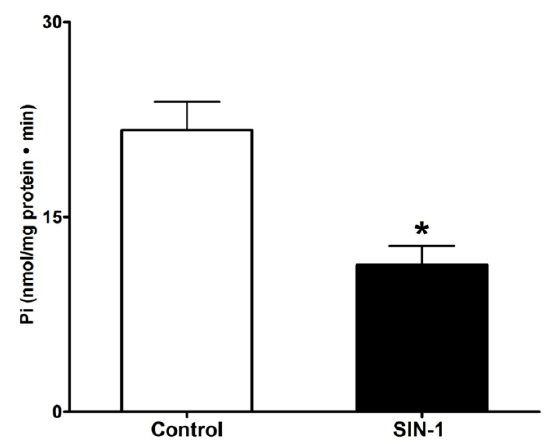
Figure 3. Effect of peroxynitrite on Na + /K + -ATPase activity in IEC-18 cells. Na+/K+-ATPase activity measured as an inorganic phosphate released was significantly diminished by SIN-1 treatment in IEC-18 cells. n = 3, * p < 0.02.